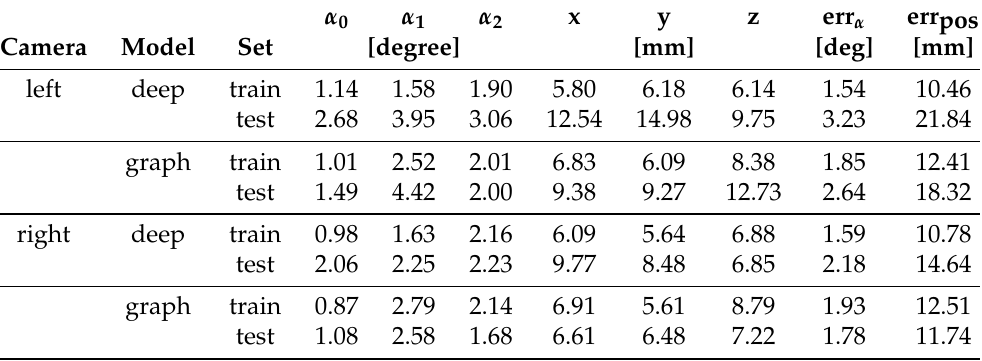
Figure 9. Comparison of the angle prediction accuracy for graph fitting and sparse CNN on the training data set, learned on the image from the right camera. The shaded area indicates that the robotic arm is in front of the camera, and it may cause a loss of accuracy. Table 3. The accuracy for two models is compared: Graph fitting and sparse CNN on the training and test data sets. ( α 0 , α 1 , α 2 , x , y , z are mean absolute errors for angles and positions in comparison (cid:112) x 2 + y 2 + z 2 is error of to a real robot position; err α is averaged value; errpos =